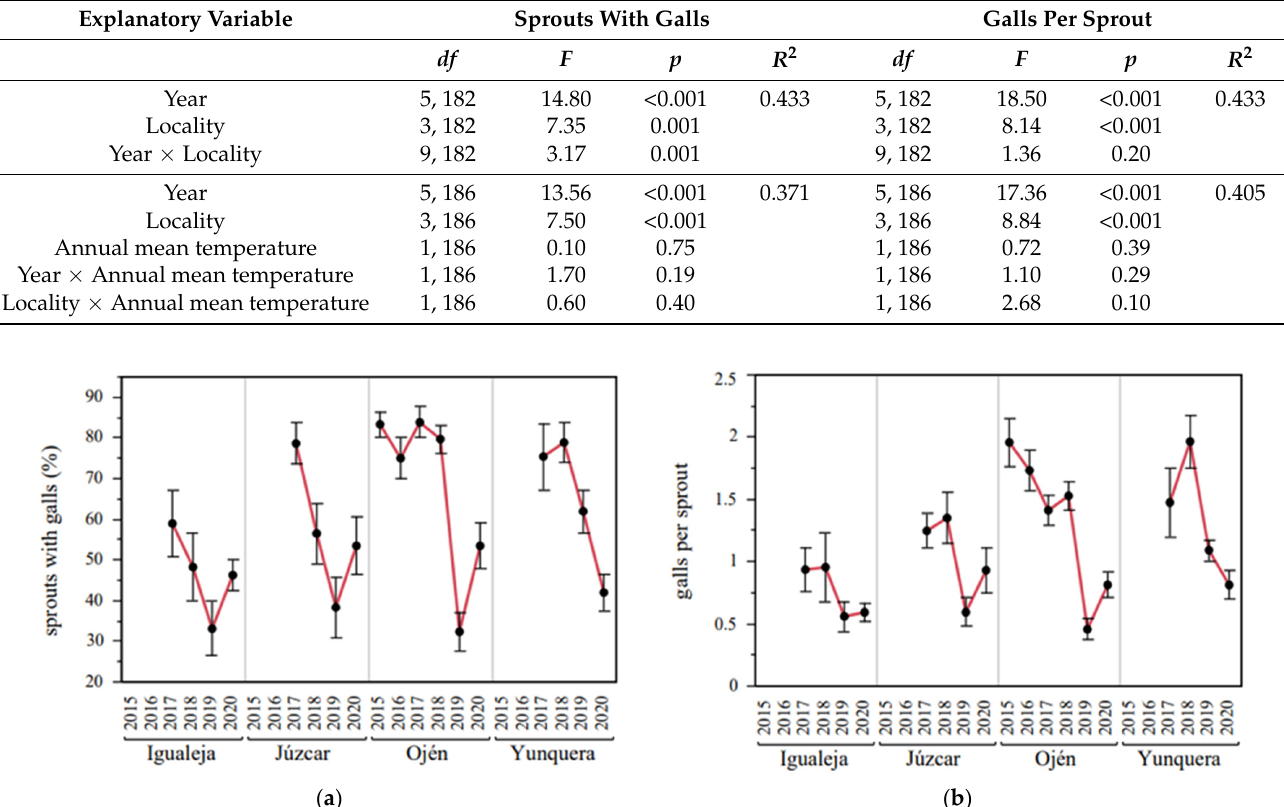
Table 4. Above, GLM results showing the effects of year × locality on the rate of sprouts with CGW galls and on the number of CGW galls per sprout. Below, GLM results showing the effects of year × annual mean temperature + locality annual mean temperature on the same damage measures. See significant post hoc differences in Table S3.